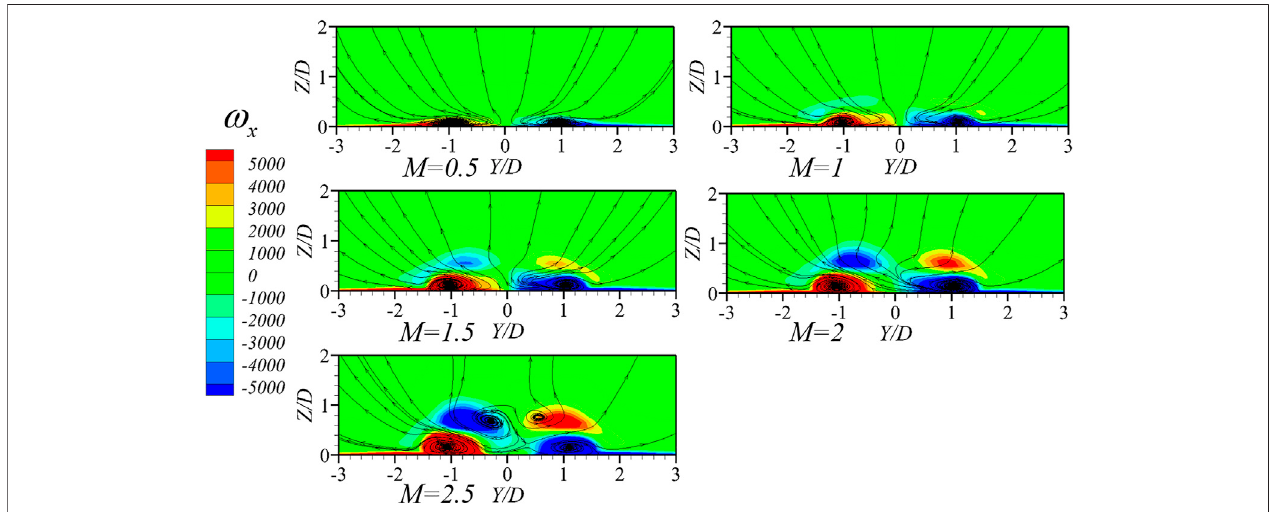
FIGURE6| DetailsofcoolingairinC/L (cid:2) 0.5case. (A) 3Dstreamlinesofcoolingair, (B) streamlineandadiabaticcoolingeffectivenesscontouratd – dplane,and (C) X-direction vorticity contour and streamline at X/D (cid:2) 2 plane.